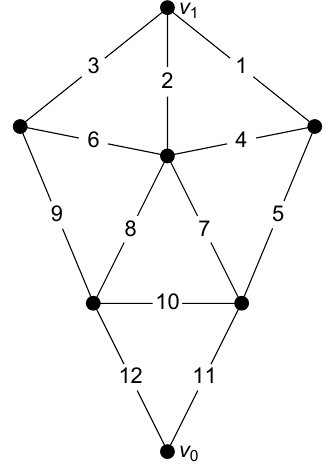
Figure 3: A planar network with two boundary vertices v 0 , v 1